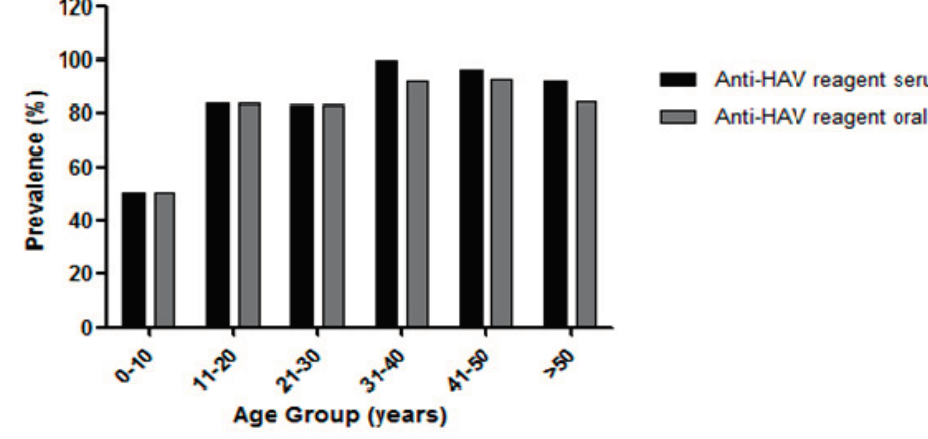
Figure 2. Total anti-HAV prevalence in serum and oral fluid by age group from individuals linving in difficul-to-access areas of South Pantanal,